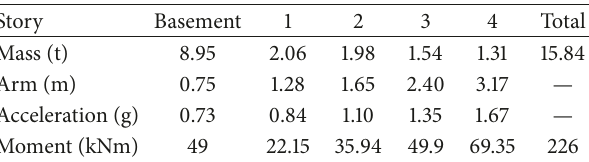
Table 7: Overturning moment